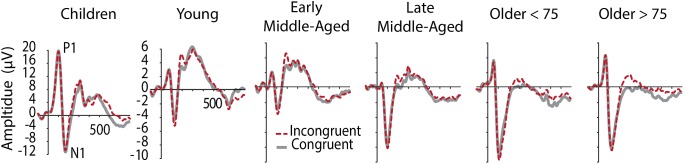
Grand averaged ERPs at occipital electrodes (averaged across O1 and O2), showing visual components P1 and N1 in C (gray, solid) and IC (red, dashed) conditions. Note the different y-aches scaling for children.